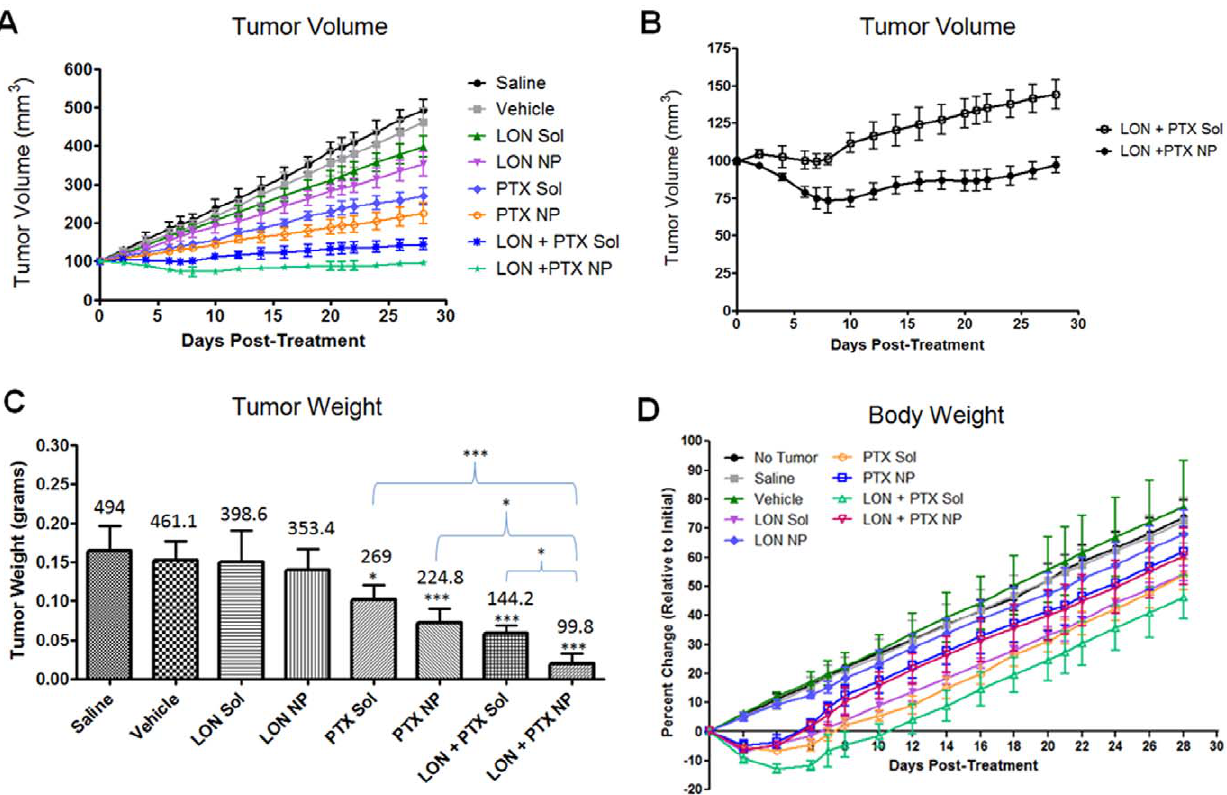
Figure 3. Tumor volume, tumor weight, and body weight after treatment. Efficacy of the combination nanoparticle therapy was assessed by measuring changes in tumor volume from 0–28 days post-treatment and by measuring the terminal tumor weight at 28 days post-treatment. Day 0 was the first day of treatment. Body weight was used as a toxicity parameter and was measured from 0–28 days post-treatment. For all graphs, each data point represents the mean 6 SD with an n =4. ( A ) Tumor volume. Mice were treated with one of eight treatments via tail vein injection; saline (black circles), vehicle (blank nanoparticles; gray squares), lonidamine solution (LON Sol; green triangles), lonidamine nanoparticles (LON NP; purple inverted triangles); paclitaxel solution (PTX Sol; light blue diamonds), paclitaxel nanoparticles (PTX NP; orange open circles), lonidamine and paclitaxel combination solution (LON + PTX Sol; dark blue asterisks), and lonidamine and paclitaxel combination nanoparticles (LON + PTX NP; light green stars). ( B ) Tumor volume (of combination therapy). To clarify the difference between lonidamine and paclitaxel combination treatment in solution form (LON + PTX Sol; open circles) compared to nanoparticle treatment (LON + PTX NP; closed circles), these two groups were graphed separately here. ( C ) Tumor weight. The terminal tumor weight (at 28-days post-treatment) was plotted for each treatment group. The number above each bar represents the average terminal tumor volume (from panel A). The asterisks directly above the error bars indicate significance between saline and the indicated group (*p , 0.05, ***p , 0.001). ( D ) Body weight. Body weight was measured and plotted as percent change (relative to initial body weight) from 0–28 days post-treatment. The groups include; no tumor (black circles), saline (gray squares), vehicle (green triangles), lonidamine solution (LON Sol; purple inverted triangles), lonidamine nanoparticles (LON NP; light blue diamonds), paclitaxel solution (PTX Sol; orange open circles); paclitaxel nanoparticles (dark blue open squares), lonidamine and paclitaxel combination solution (LON + PTX Sol; light green open triangles), and lonidamine and paclitaxel combination nanoparticles (LON + PTX NP; pink inverted open triangles).